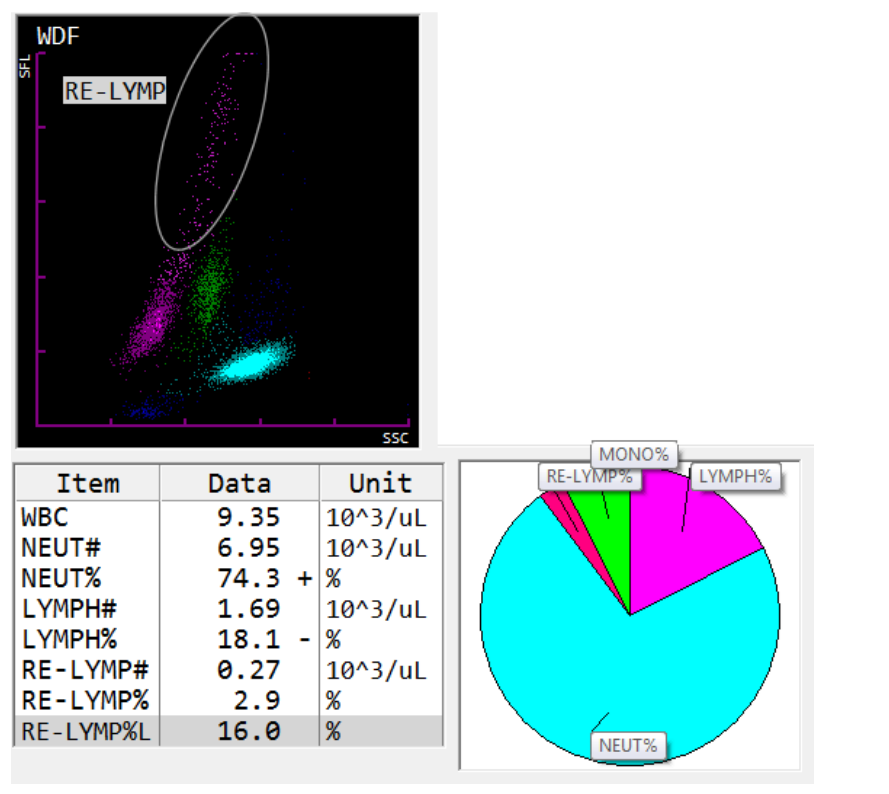
Figure A1. Sample screenshot from the Sysmex XN-1500 analysis software showing the distribution of leukocytes (plot SSC vs. SFL) with selected reactive lymphocytes (RE-LYMP).